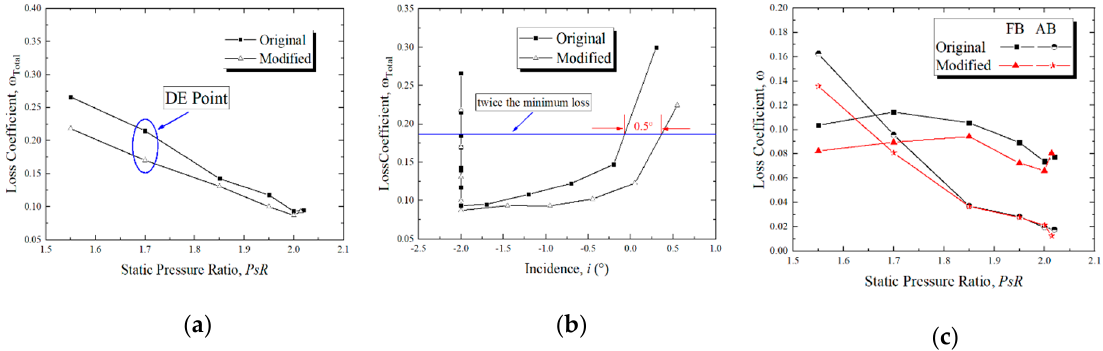
Figure 10. Comparison of the basic and optimized blade performances. ( a ) Static pressure ratio–total pressure loss coefficient, ( b ) Incidence–total pressure loss coefficient, ( c ) total pressure loss coefficient of FB and AB.